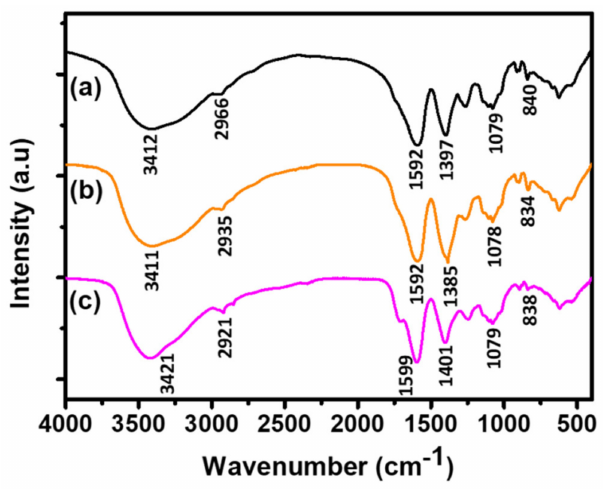
Figure 6. Fourier transform infrared (FT-IR) spectra of ( a ) SS extract, ( b ) SS-AgNPs, and ( c )